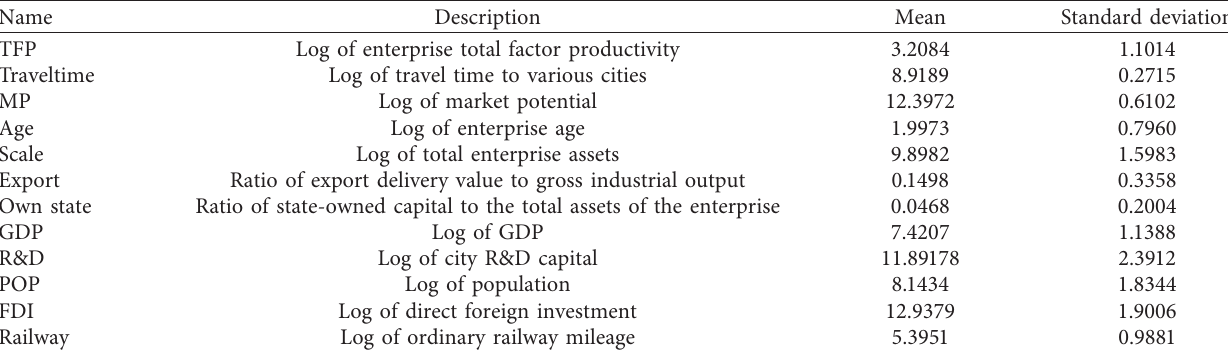
Table 4: Statistical description of the main